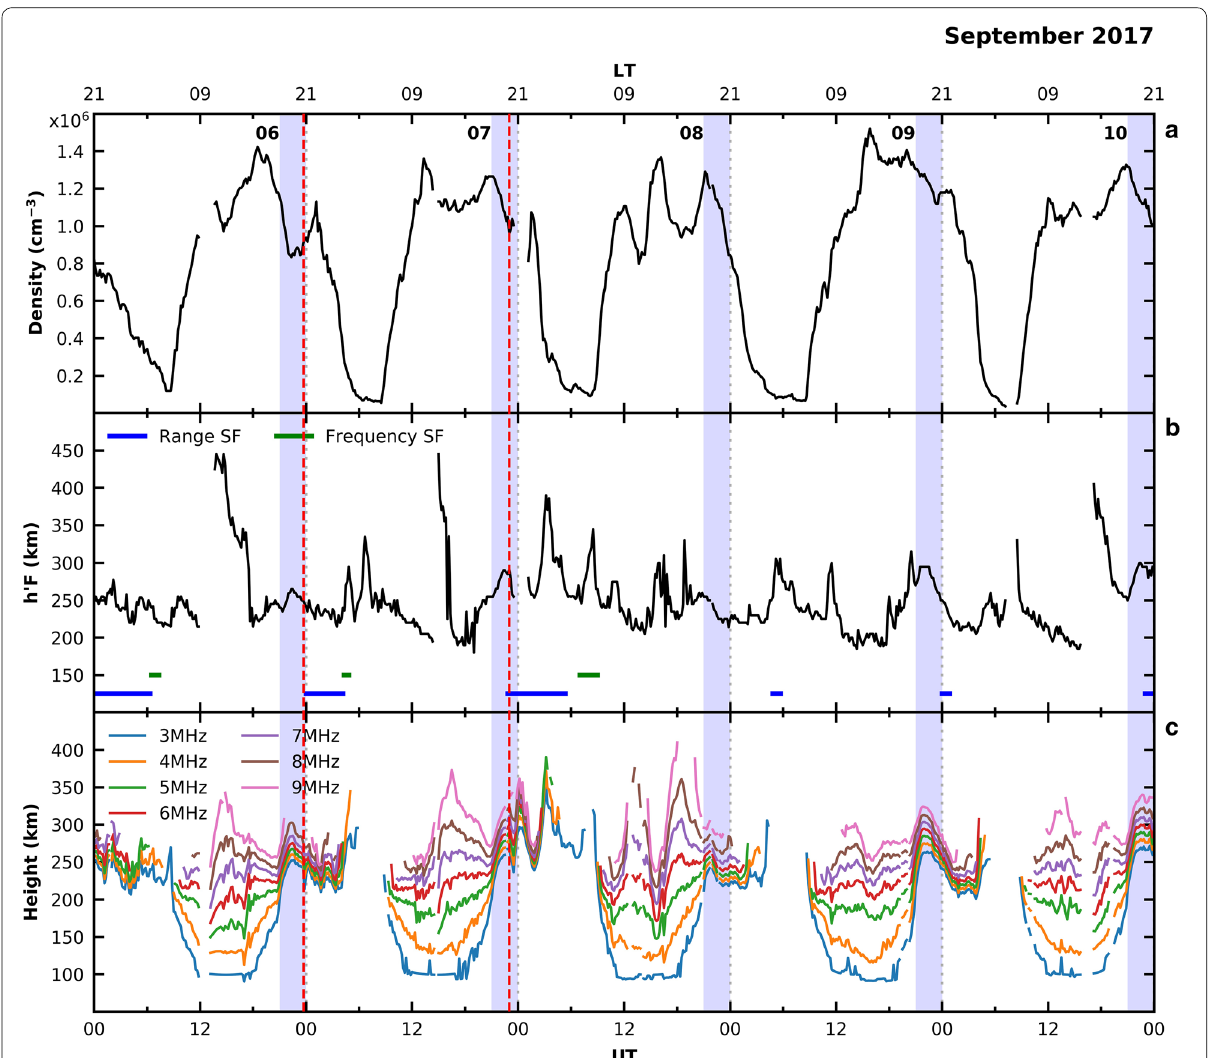
Fig. 6 F layer peak density ( a ), minimum virtual height of F layer h ʹ F ( b ) and F layer true heights for the 3–9 MHz frequencies ( c ) measured by the São Luís Digisonde for the storm period of 6 to 10 September 2017. The color correspondence for each frequency is shown in the left part of the lower panel. Horizontal traces represent range SF (blue) and frequency SF (green). The light blue shaded areas represent the prereversal period of 21:00–24:00 UT (18:00–21:00